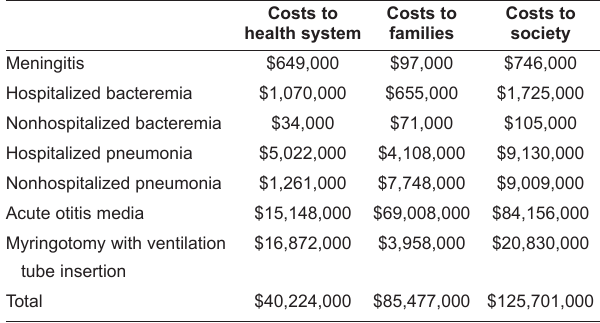
Figure 1) Number of cases of pneumococcal-related outcomes in a cohort of 340,000 Canadian children between six months and nine years of age. MVT* Myringotomy with ventilation tube